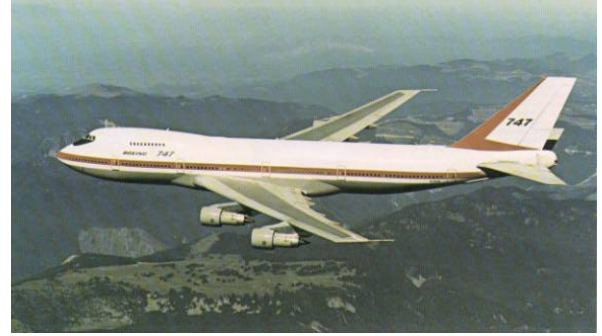
Fig 1. PAN AM Flight 103, December 21,